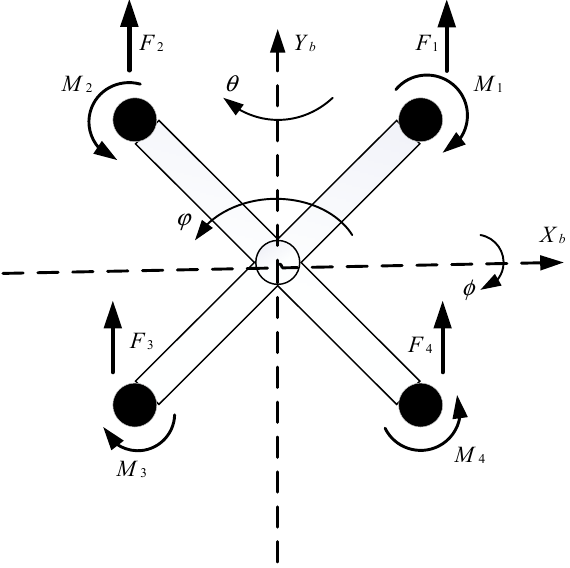
Figure 1. The illustration of UAV kinematics.